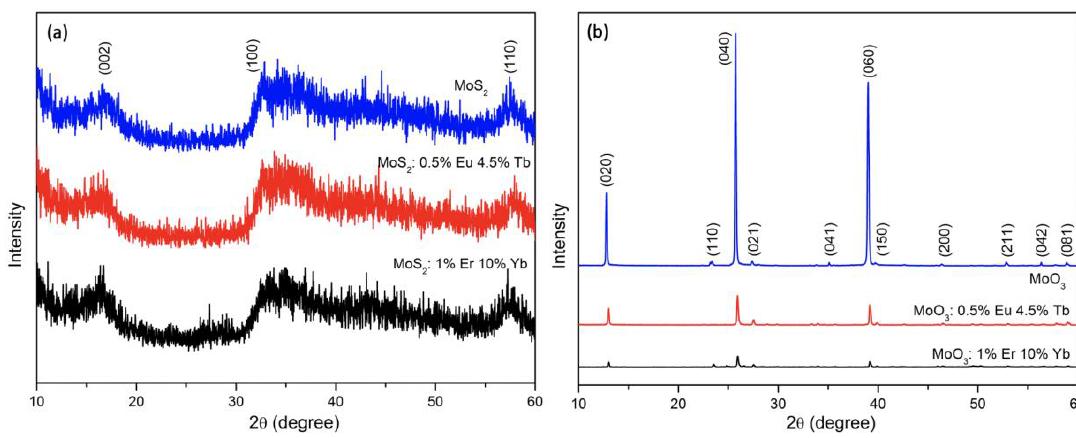
Figure 1. XRD patterns of ( a ) MoS 2 and ( b ) α -MoO 3 samples.